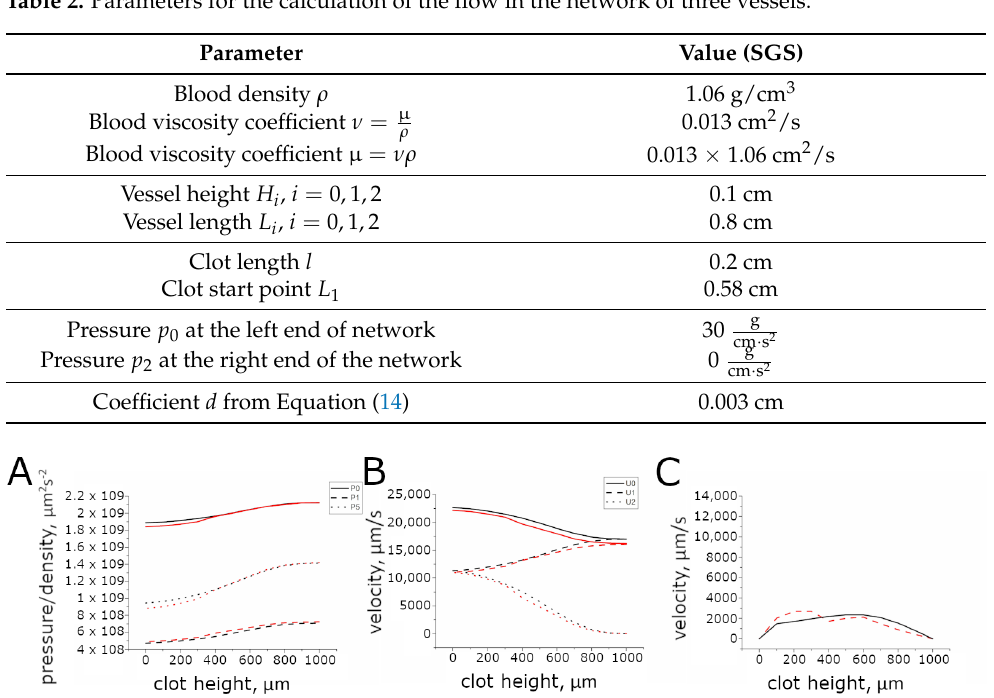
Table 2. Parameters for the calculation of the flow in the network of three vessels.